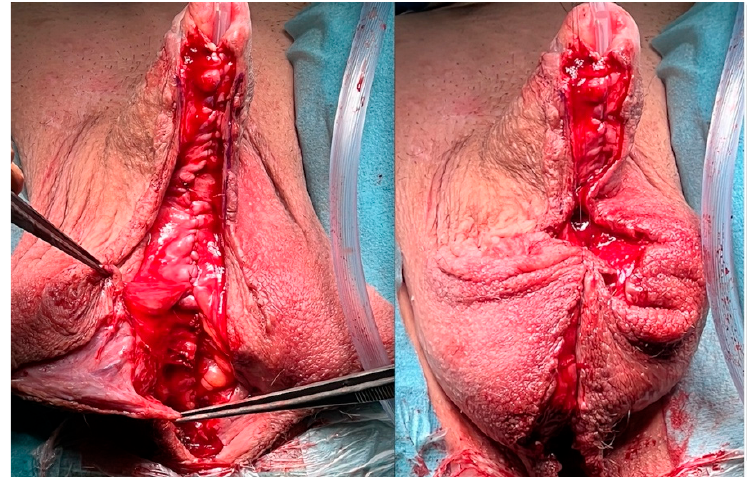
Figure 10. Remodeling the normal anatomy by reproducing a